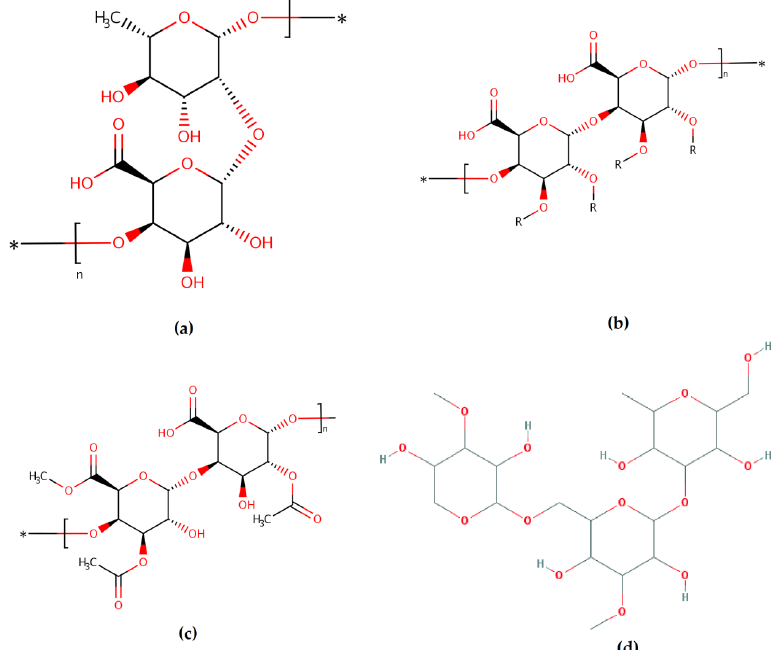
Figure 2. Rhamnogalacturonan type I (RG-I) ( a ) and type II (RG-II) ( b ), homogalacturonan (HG) ( c ) and arabinogalactan (AG) ( d ) structures. *—the compounds can bind to rhamnose, galactose, arabinose [29].